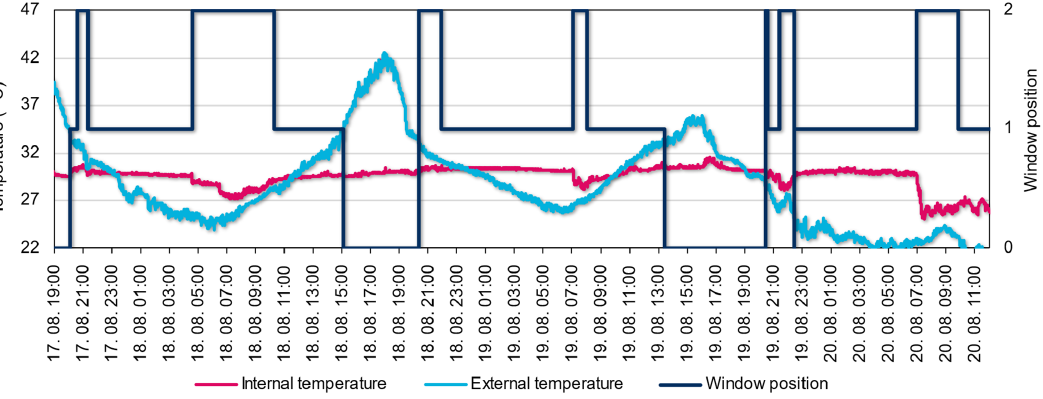
Figure 16. External and internal temperatures in small bedroom and window position (“0”—closed, “1”—tilted,” 2”—fully open).